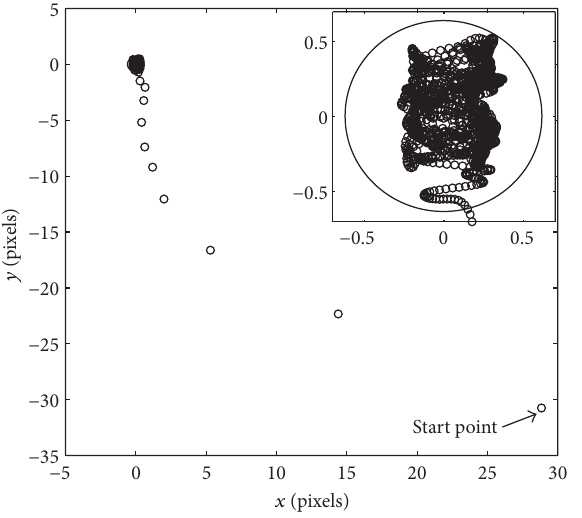
Figure 13: Tracking error (experiment on October 5).